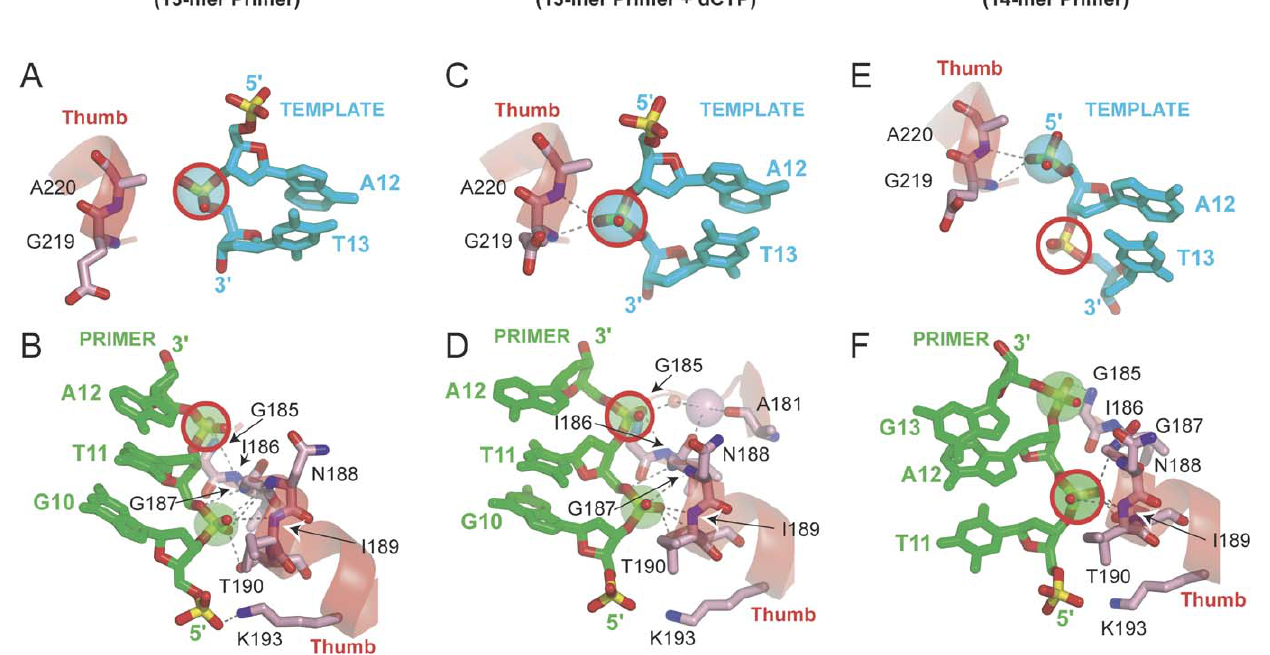
Figure 6. Details of Changes in Dpo4 Thumb Domain Contacts with Backbone Phosphates on the oxoG-Modified Template-Primer DNA Associated with the Nucleotide Binding and Incorporation Steps (A) Intermolecular contacts between the thumb domain (red) and the template strand (cyan) in the preinsertion binary complex. The phosphate groups interacting with Dpo4 amino acids are highlighted by shaded spheres. The phosphate group of T13 of the template strand is circled for reference. (B) Intermolecular contacts between the thumb domain (red) and the primer strand (green) in the preinsertion binary complex. The phosphate groups interacting with Dpo4 amino acids are highlighted by shaded spheres. The phosphate group of A12 of the primer strand is circled for reference. (C) Intermolecular contacts between the thumb domain (red) and the template strand (cyan) in the insertion ternary complex. The intermolecular contacts involving the thumb are retained on proceeding from the preinsertion binary complex (in A) to the insertion ternary complex (in C) on dCTP binding. (D) Intermolecular contacts between the thumb domain (red) and the primer strand (green) in the insertion ternary complex. The intermolecular contacts involving the thumb are retained on proceeding from the preinsertion binary complex (in B) to the insertion ternary complex (in D) on dCTP binding. (E) Intermolecular contacts between the thumb domain (red) and the template strand (cyan) in the postinsertion binary complex. The intermolecular contacts involving the thumb are translocated by one nucleotide step on proceeding from the insertion ternary complex (in C) to the postinsertion binary complex (in E) upon dCTP incorporation. (F) Intermolecular contacts between the thumb domain (red) and the primer strand (green) in the postinsertion binary complex. The intermolecular contacts involving the thumb are translocated by one nucleotide step on proceeding from the insertion ternary complex (in D) to the postinsertion binary complex (in F) upon dCTP